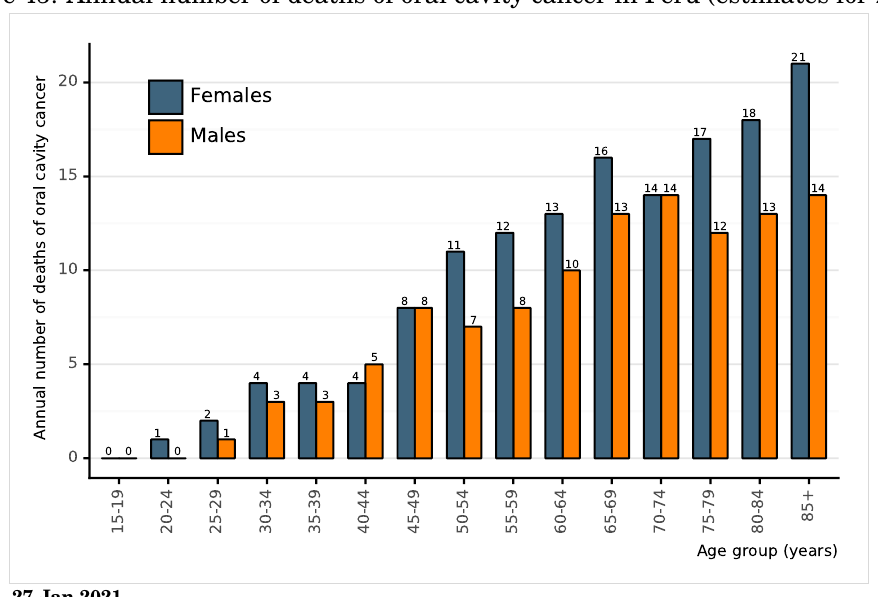
Figure 45: Annual number of deaths of oral cavity cancer in Peru (estimates for